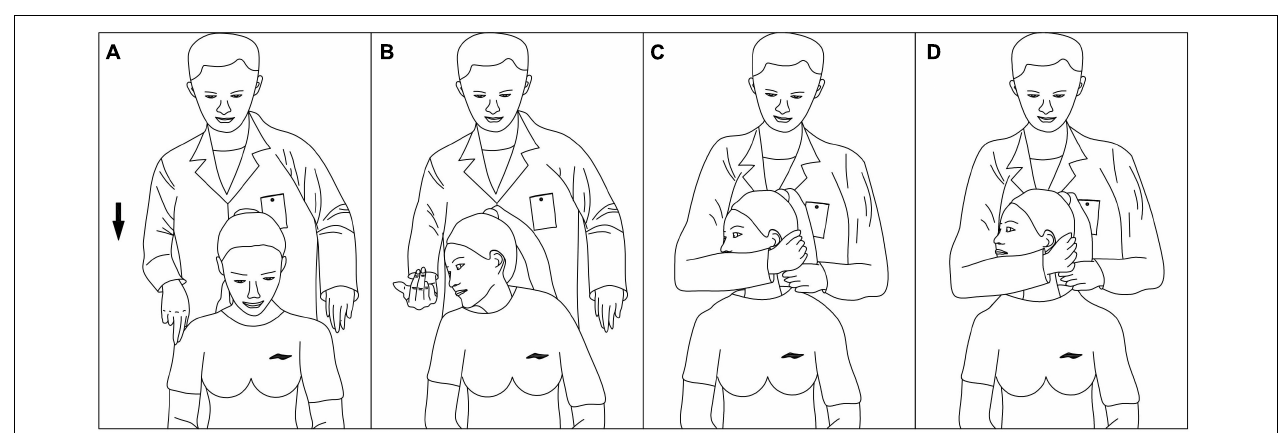
FIGURE 3 | Process of the oblique pulling manipulation. (A) Flex. (B) Active rotation. (C) Passive rotation. (D) Instant pull.